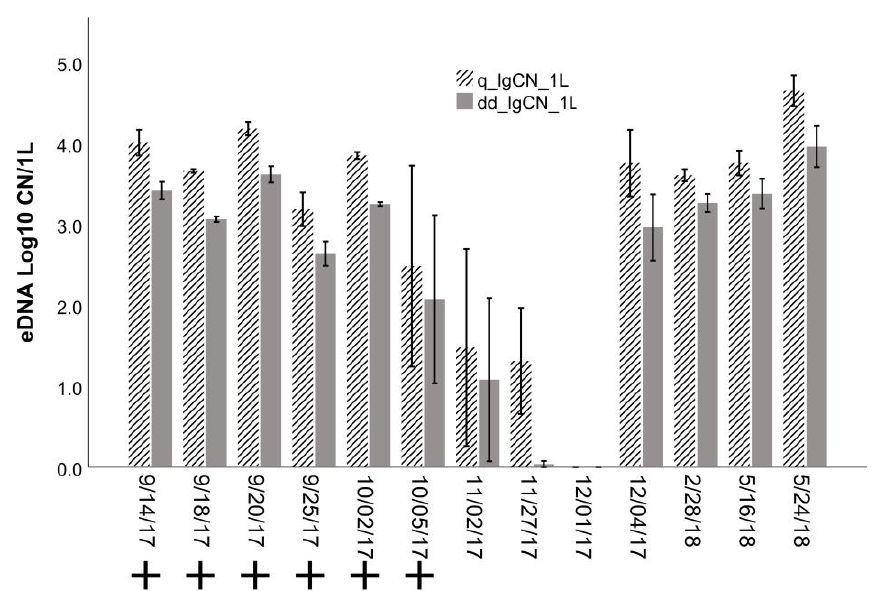
Figure 3. Seasonal mean round goby ( Neogobius melanostomus ) environmental DNA (eDNA) concentrations (log 10 copy number per liter (CN/L)) ± standard error (SE) in water samples collected at the Lake Michigan breakwalls and analyzed using quantitative PCR (qPCR) and droplet digital PCR (ddPCR). Black plus signs indicate corresponding hook and line angling.